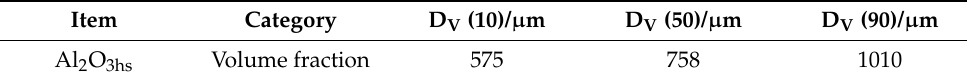
Table 2. Particle size distribution of Al 2 O 3hs.